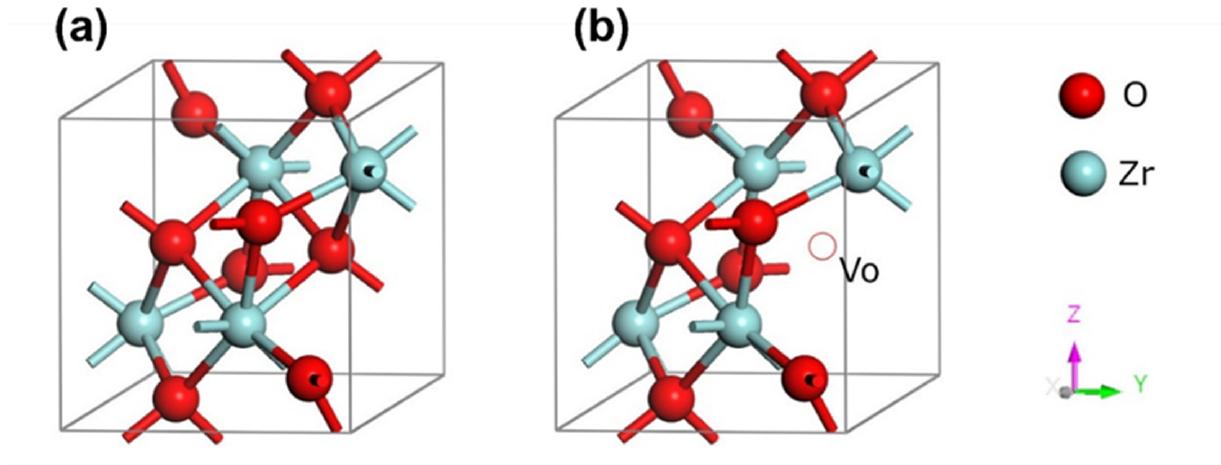
Figure 6. Monoclinic ZrO 2 crystal structures ( a ) without and ( b ) with oxygen vacancy.